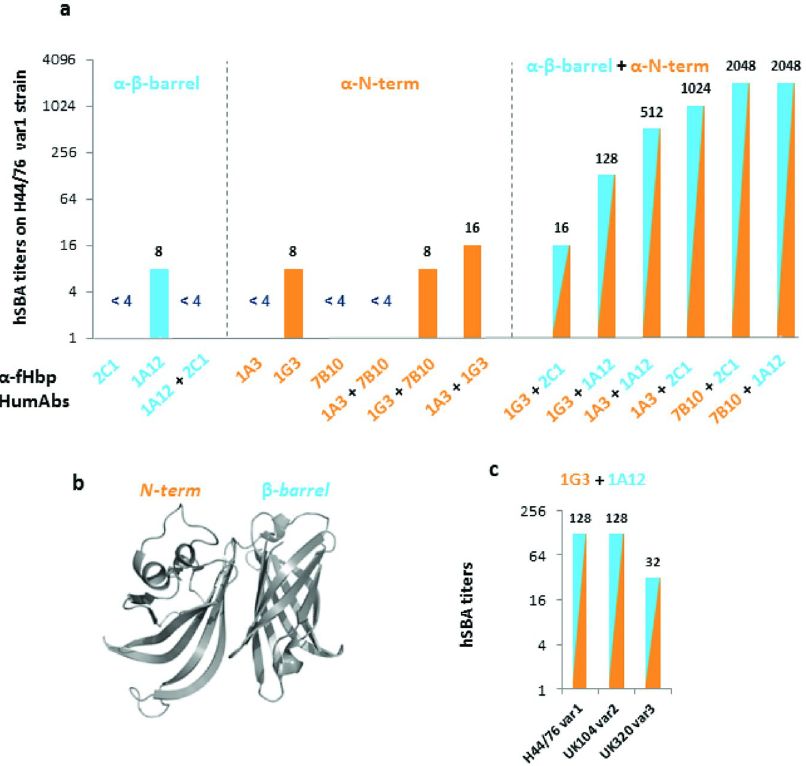
Figure 3. Functionality of anti-fHbp mAbs assessed by the Serum Bactericidal Activity Assay. Human serum bactericidal assay 27 titers with combinations of mAbs targeting N-terminal (orange) and beta-barrel (blue) domains of fHbp; ( a ) localization of N-terminal and beta-barrel domain on three-dimensional structure of fHbp 19 ; ( b ) hSBA titers of cooperative mAbs combination (1G3 + 1A12) on Neisseria meningitidis strains expressing different fHbp variants ( c ). Threshold for positive titer was defined as > 4, antibody couples are considered cooperative if the titer obtained with mAbs combination is at least fourfold higher than titer obtained with single mAbs.